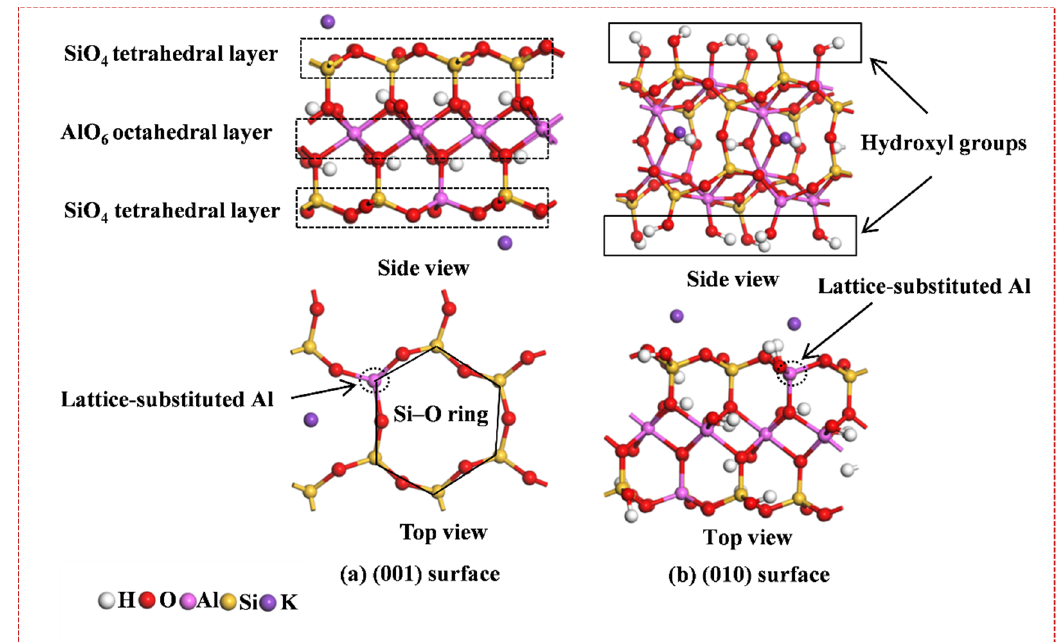
Figure 1. Structures of illite surfaces: ( a ) (001) surface and ( b ) (010) surface.